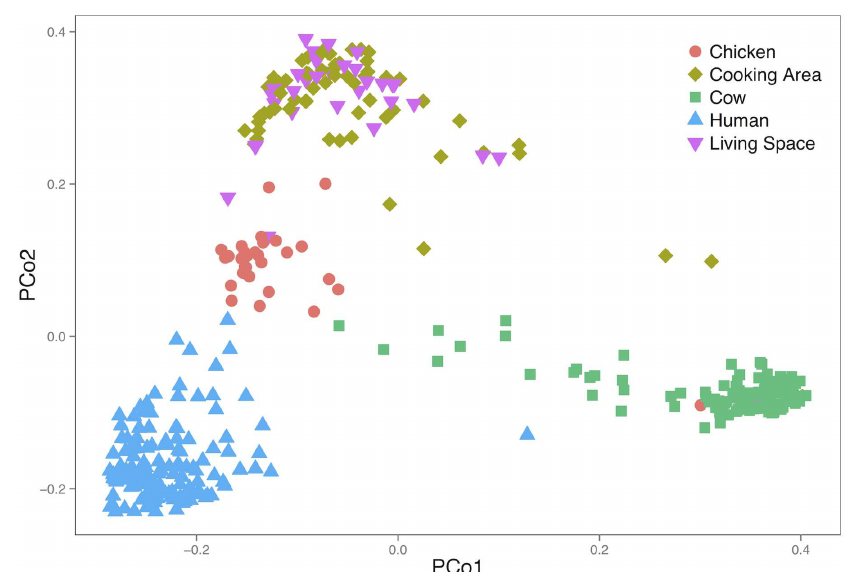
Fig 2. Principal coordinate analysis of unweighted UniFrac distances representing phylogenetic clustering of gut and environmental microbiome constituents in samples from households in western Kenya.